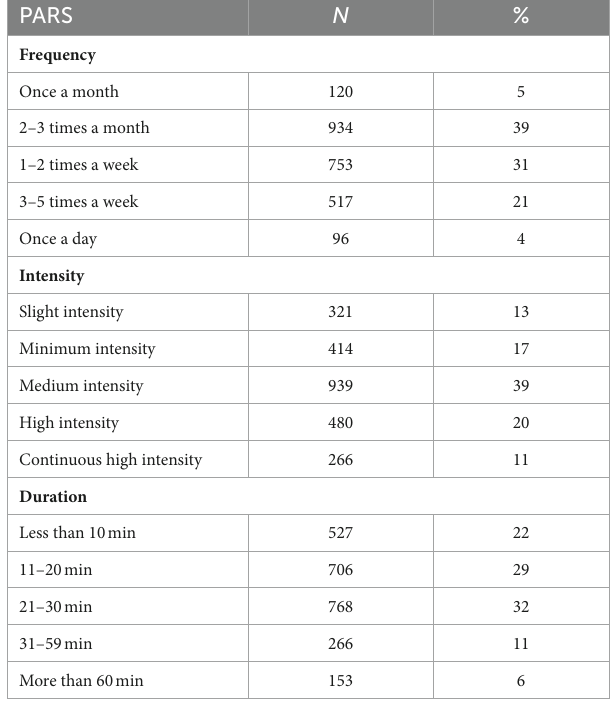
TABLE 1 Basic information of extracurricular physical exercise of junior high school students. PARS